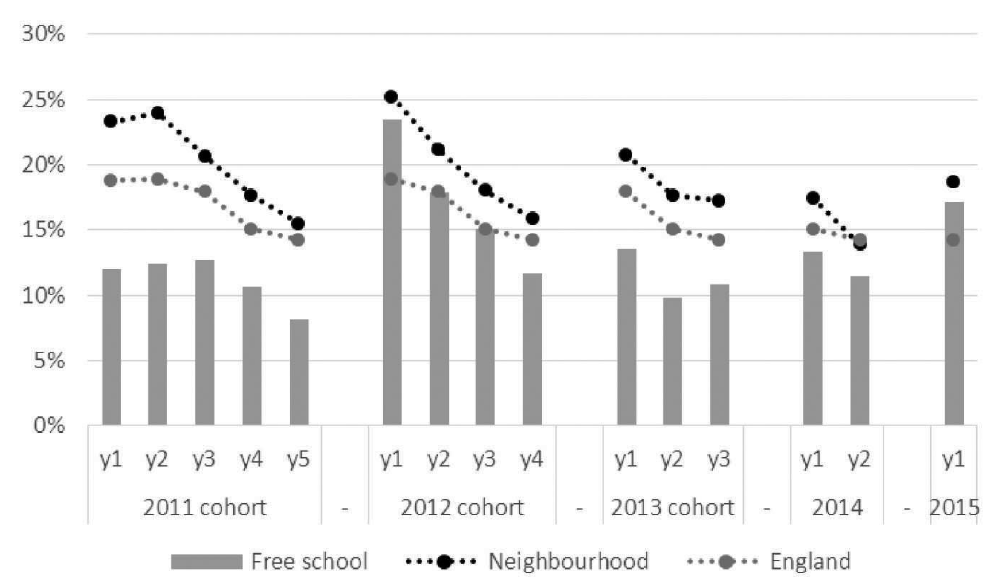
Figure 7: Pupils eligible for FSM at primary free schools in Year R compared to their